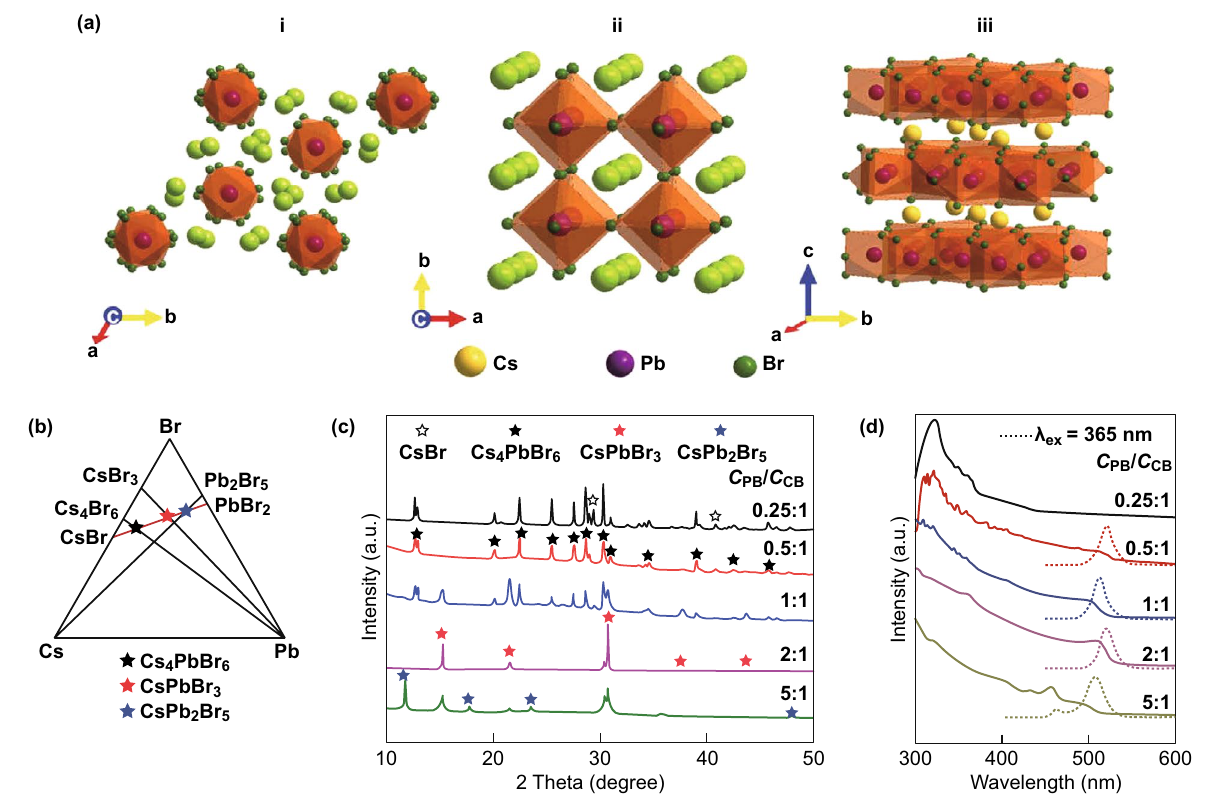
Fig. 1 Influence of C PB : C CB ( C PB = PbBr 2 , C CB = CsBr = 0.04 M) on the composition and optical properties of Cs–Pb–Br nanocrystals. a Crys- tal structure of Cs 4 PbBr 6 (i), CsPbBr 3 (ii) and CsPb 2 Br 5 (iii). b Ternary phase diagram of Cs, Pb and Br elements. Cs 4 PbBr 6 , CsPbBr 3 and CsPb 2 Br 5 fall on the line connecting PbBr 2 and CsBr in the diagram. c XRD results at different C PB : C CB . d PL and UV–Vis absorption spectra of the nanocrystals prepared at different